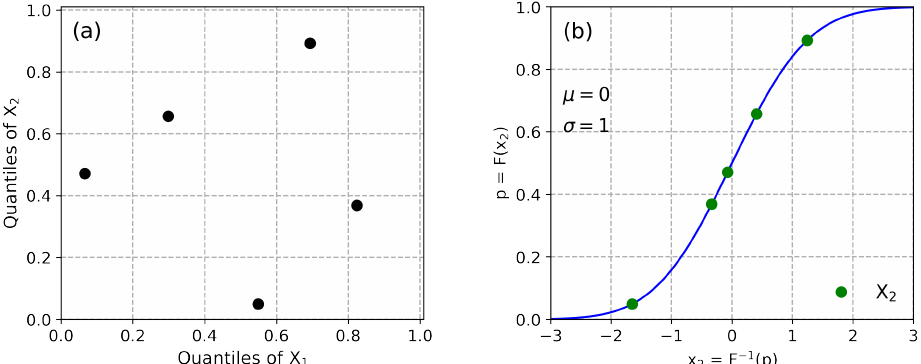
Figure 2. ( a ) A sampling design with n = 5 realizations generated by CLHS in a two-dimensional sampling space where the random variables are independent, ( b ) Mapping the quantiles according to the standard Gaussian distribution using the inverse transform